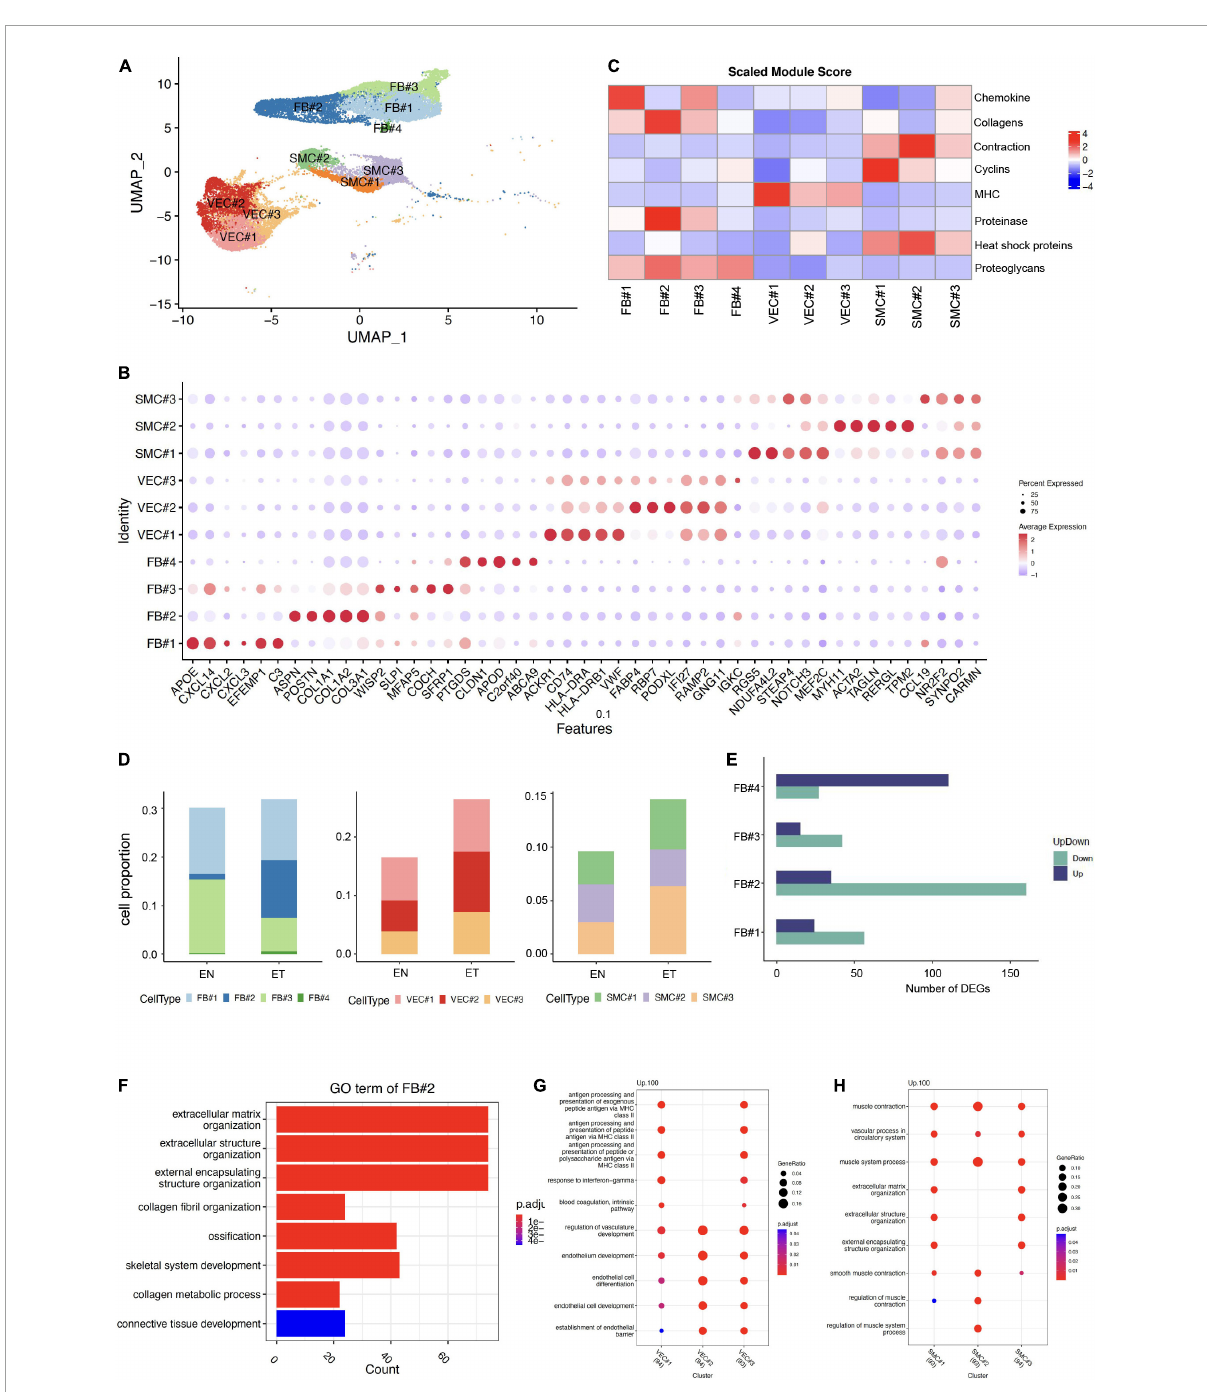
FIGURE2 Characteristics of extracellular matrix (ECM)-related populations in earlobe keloid. (A) ECM-related populations were further divided into different subpopulations, including FB (FB#1, FB#2, FB#3, FB#4), VEC (VEC#1, VEC#2, VEC#3), and SMC (SMC#1, SMC#2, SMC#3). (B) Module scores of eight features (or functions) in each ECM-related subpopulation. (C) Dot plot shows the classical markers of each ECM-related subpopulation. Dot size presents the proportion of cells within the group expressing each gene, and dot color is related to its expression level. (D) The cell proportions of ECM-related subpopulation between normal skin sample (EN) and earlobe keloid samples (ET). (E) Number of DEGs in each fibroblast subpopulations between normal skin (EN) and earlobe keloid samples (ET) (Wilcoxon rank-sum test, Bonferroni correction, log2 fold change (log2FC) cutoff of 0.25, and P -value of < 0.05). Purple bars indicate upregulated genes, and green bars indicate downregulated genes in earlobe keloid. (F) Gene ontology (GO) biological process enrichment analysis of upregulated DEGs in mesenchymal fibroblast (FB#2) between earlobe keloid and normal skins. Its gene functions were mainly related to ECM organization, ossification, and skeletal system development. (G) GO biological process enrichment analysis of each VEC subpopulation. (H) GO biological process enrichment analysis of each SMC